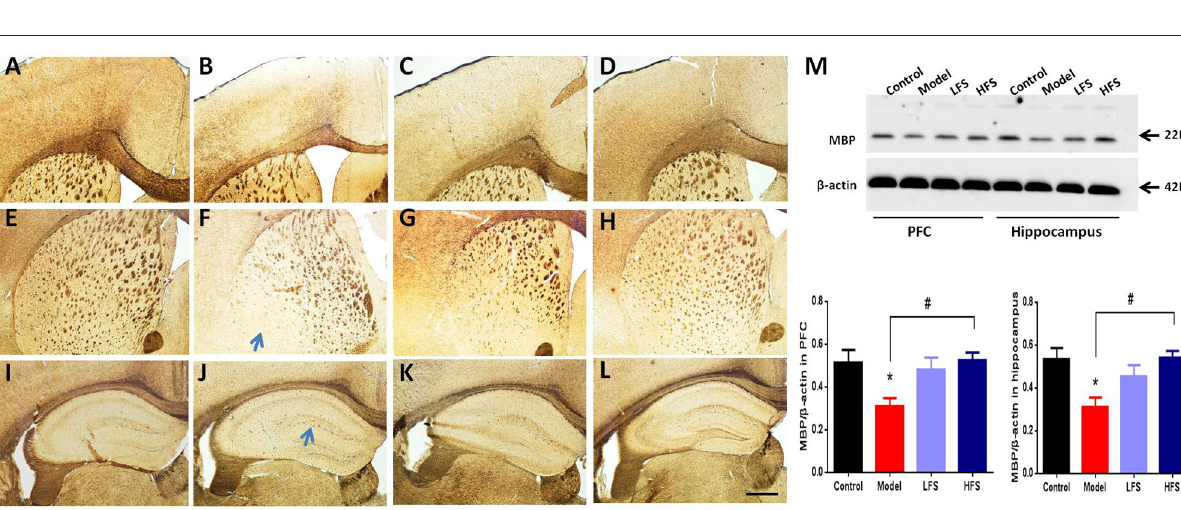
FIGURE 4 | PPI deficits in cuprizone mice are rescued by DMS. (A) Startle amplitude for all PPI test epochs. (B) PPI at 75 dB with 100ms interval. Values are expressed as mean ± SEM ( n = 12–15). ** P < 0.01 vs. control group; # P < 0.05, ## P < 0.01 vs. model group.